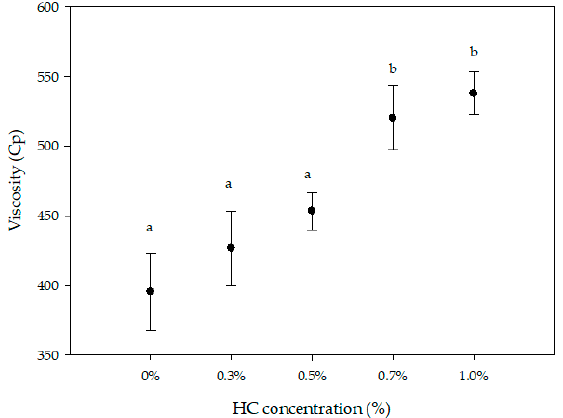
Figure 1. Beverage viscosity with different concentrations of hydrolyzed collagen (HC). Values are means ± SD based on 3 observations. Means with different lowercase letters differ ( p ≤ 0.05).